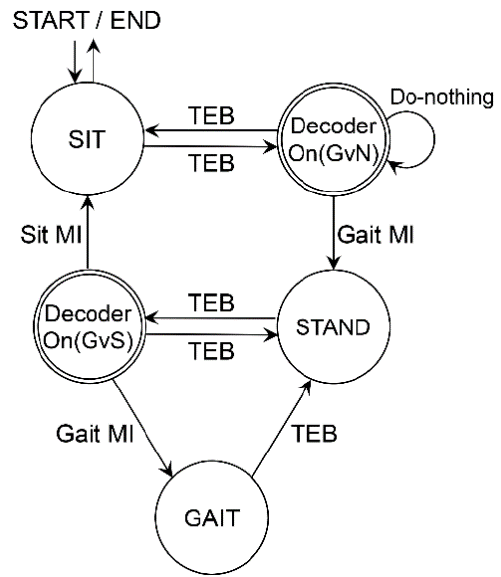
Figure 3. The finite state machine is illustrated in the diagram. The transition between states is indicated in the manner of triple eye-blink (TEB) or MI, respectively. Subjects engage MI in ‘Decoder On’ shown in double circle.